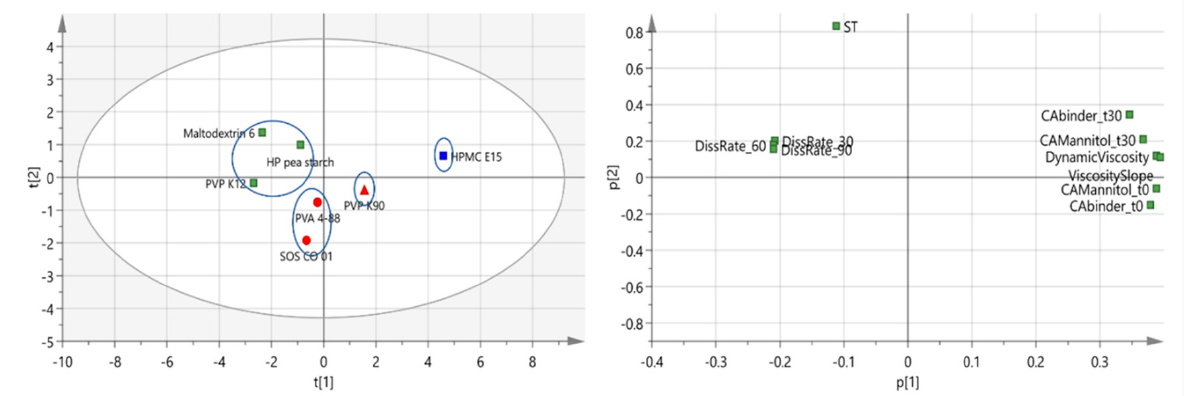
Figure 5. The score scatter plot ( left ), and the loading scatter plot ( right ) for PC 1 versus PC 2 of PCA_2 [16]. Binder clusters are encircled on the score scatter plot. The different colors on the score scatter plot refer to the L/S-ratio, which was required to obtain granules with a friability <30%.